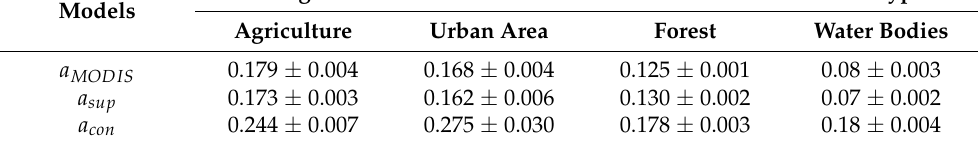
Table 4. Average ( ± 95% confidence interval) of the surface albedo estimated by MODIS ( a MODIS ), used as reference values, surface albedo estimated by the model developed in this study ( a sup ) and surface albedo estimated by the conventional model ( a con ) in agriculture, urban area, forest, and water bodies on the study area. All units are